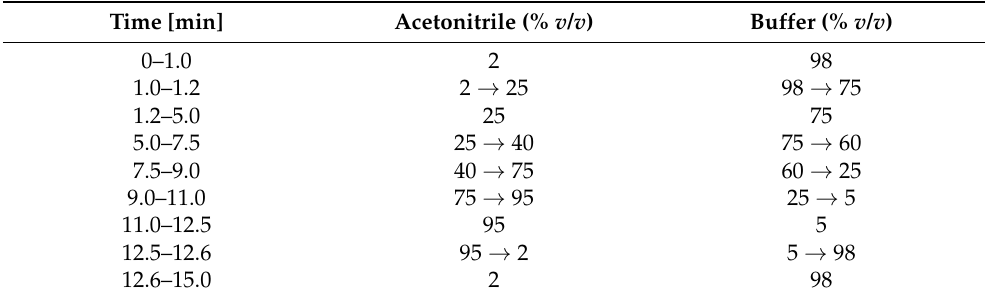
Table 5. Optimized gradient for the separation of enalapril and its related